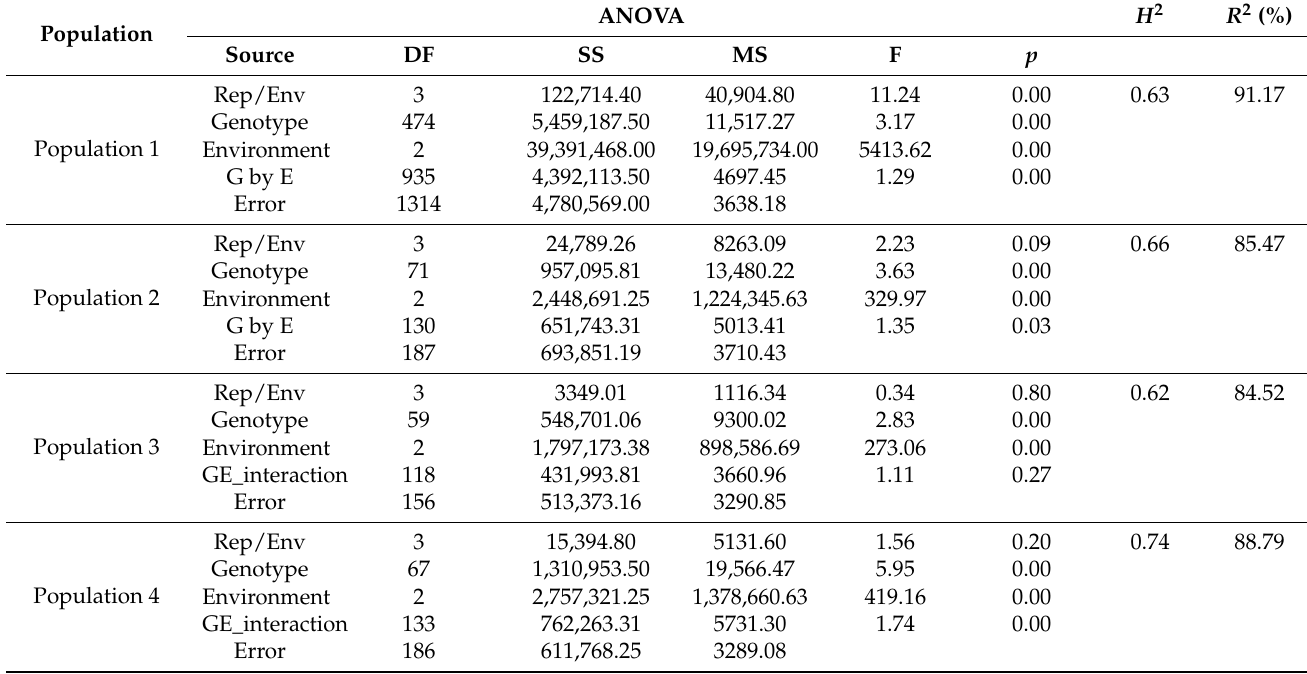
Table 2. Variance dissection of yield of the four hybrid